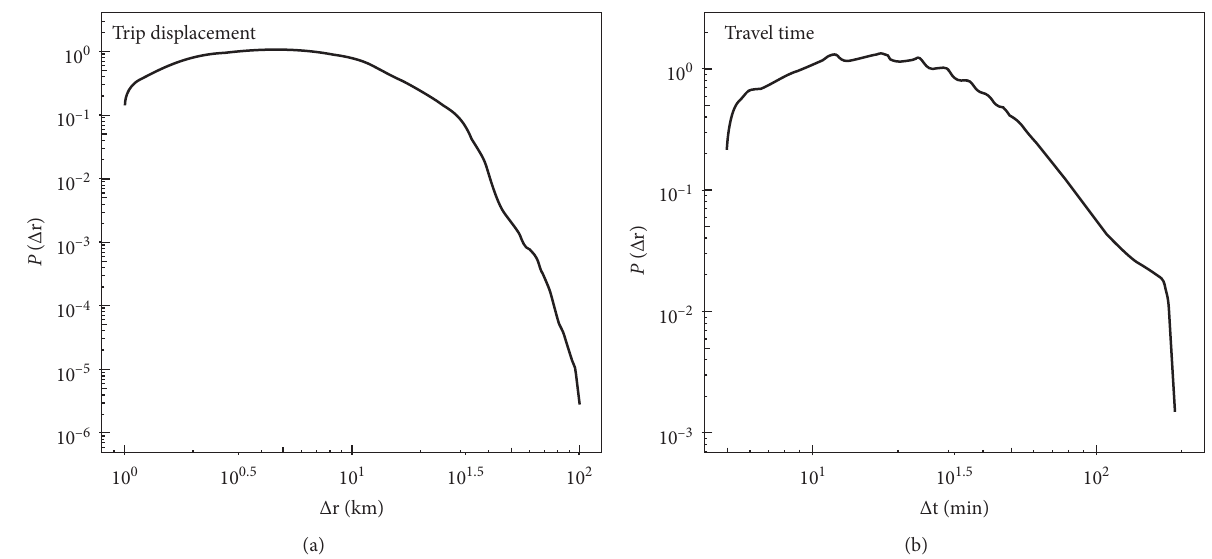
Figure 3: Observed probability density of trip displacement and travel